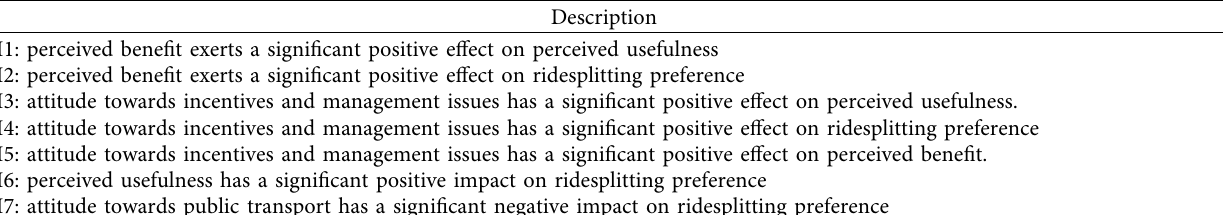
Table 4: Model hypotheses.